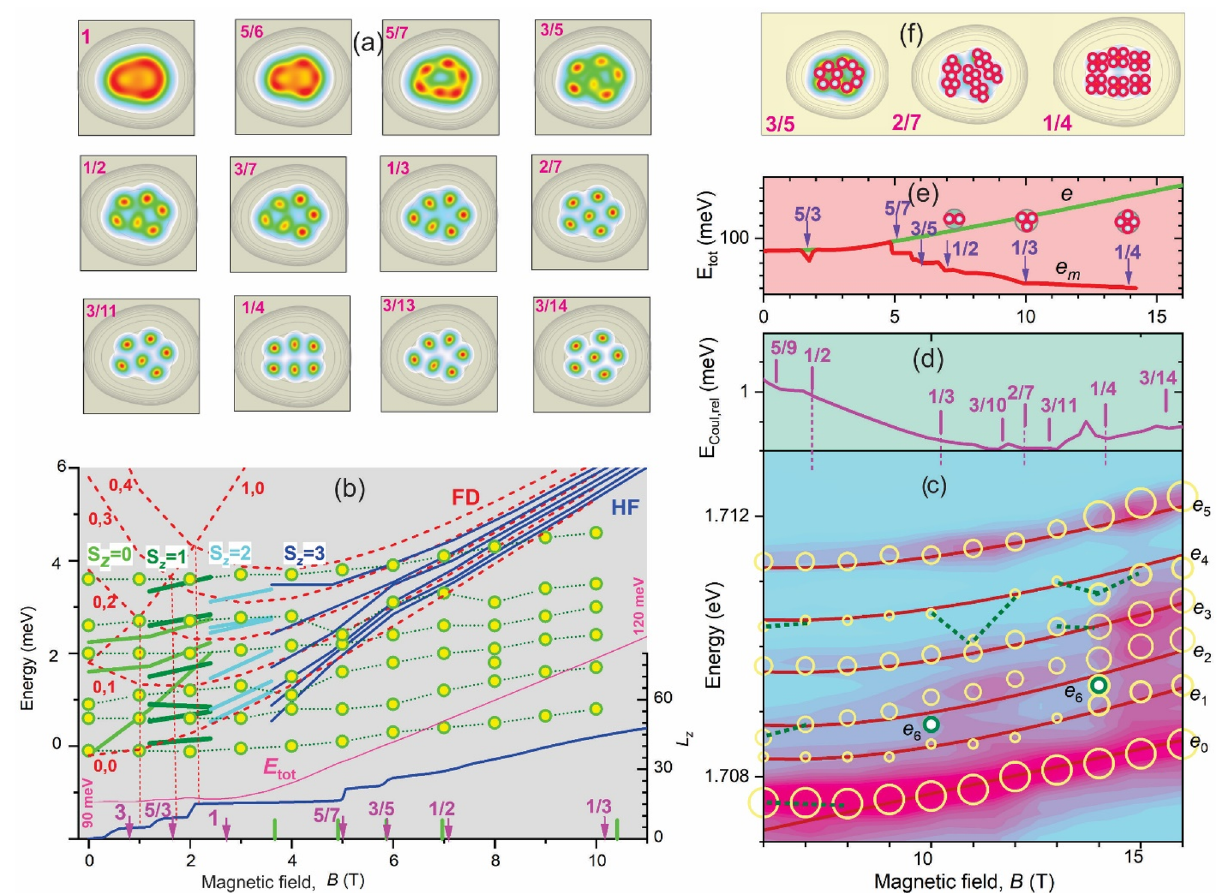
Figure 3. Calculated electron density distributions given by CI of the QD D1d for filling factors (numbers in the plots) ν = 1, 5/6, 5/7, 3/5, ½,3/7, 1/3, 2/7, 3/11, ¼, 3/13 and 3/14. Contours indicate the deformed confinement potential ( a) . Calculated total energy (thin line) ranging from 90 meV at B = 0 T to 120 meV at B = 12 T, total angular momentum L z (thick line, axis on right side) and shifts given by FD (dashed lines) and by HF S z = 0–3 (solid lines) versus a magnetic field range 0–10 T. Vertical dashed lines mark the crossing of the 1,0 and the 0, l FD levels. Solid circles are the experimental shifts of ASCs. The vertical arrows and bars on B -axis are B ν “spectrum” of non-circular and circular dot (see text), respectively ( b) . PL spectra (contour plot) and peak shifts (open circles) versus total field B and FD fit (curves) ( c) . E Coul,rel ( B ) (d) . e versus e ν E tot ( B ) and vortexes occupying single- e area (circles) for ν = 1/2, 1/3 and ¼ ( e) . Schematic e ν molecular arrangement for the QDs D4d, D1e and De4 having ν = 3/5, 2/7 and ¼, respectively (f)